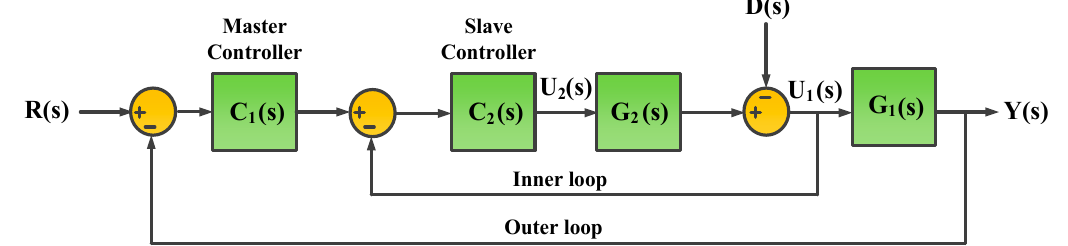
Figure 4. Block diagram of the cascade controller.